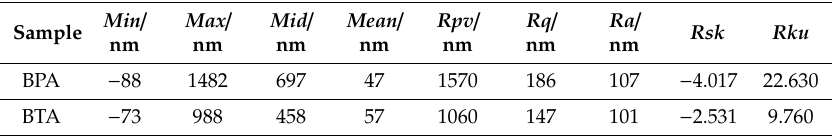
Table 12. Statistics of the quantities characteristic of the roughness on the surfaces covered with BPA and BTA.